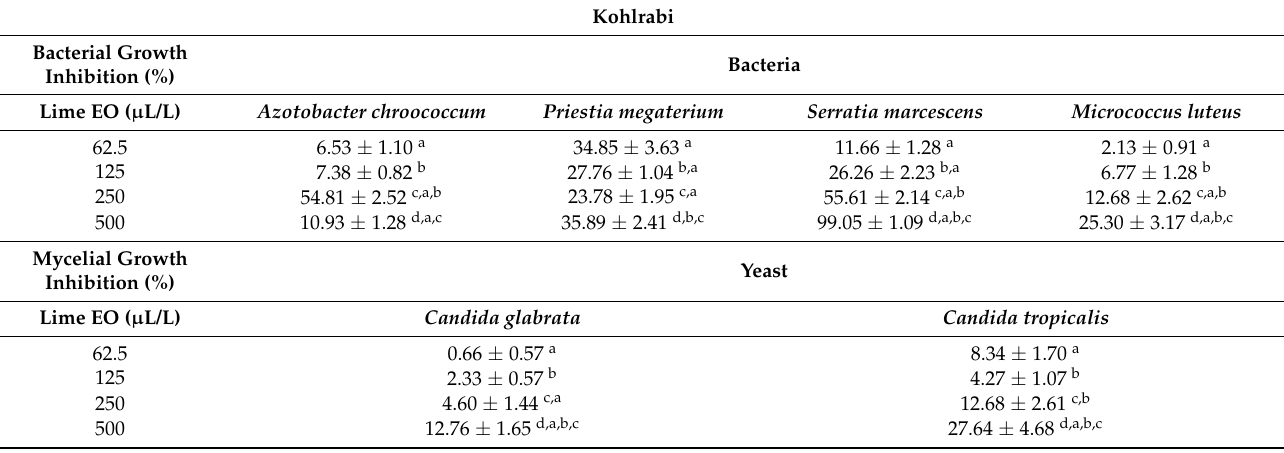
Table 6. In situ analysis of the antibacterial activity of the vapor phase of CAEO in kohlrabi.